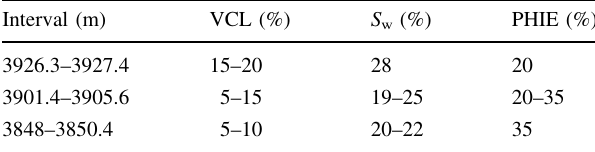
Table 3 Reservoir parameters estimated for representative